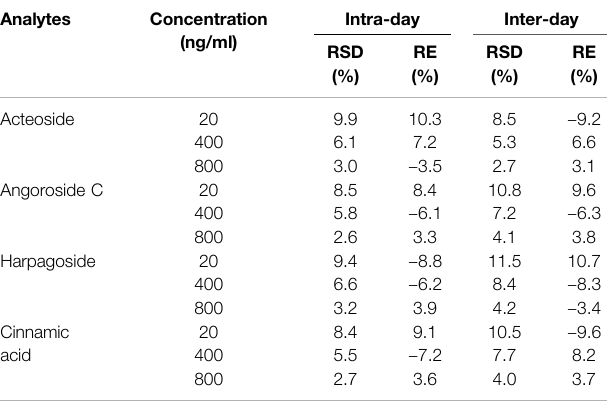
TABLE 1 | Precision and accuracy of acteoside, angoroside C, harpagoside and cinnamic acid in rat plasma (n (cid:2) 6).